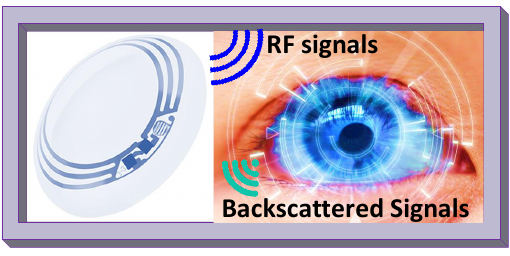
Figure 46. BackCom-based